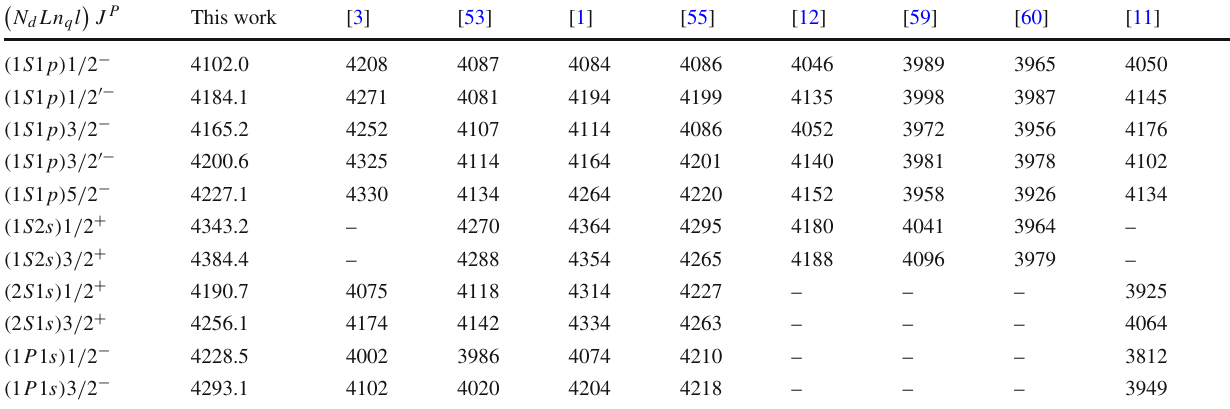
Table 13 Mass spectra of (cid:3) cc baryons(in MeV). Our results are obtained by the respective sum of the mean mass of the (cid:3) cc in Table 3, the binding energy shift(vanishes in 1S1s wave) in Table 9 and its splittings in Sect. 3 with the couplings given in Sect. 4